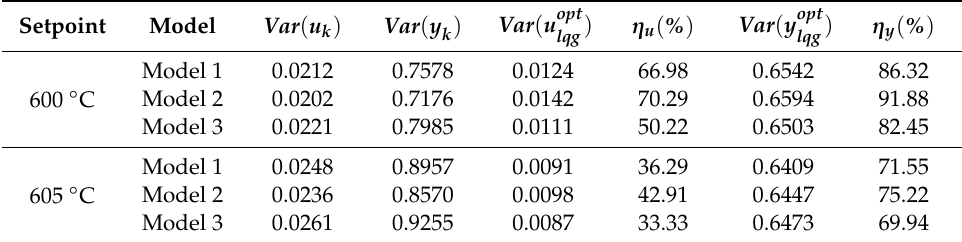
Table 2. Statistical results of steady state performance.